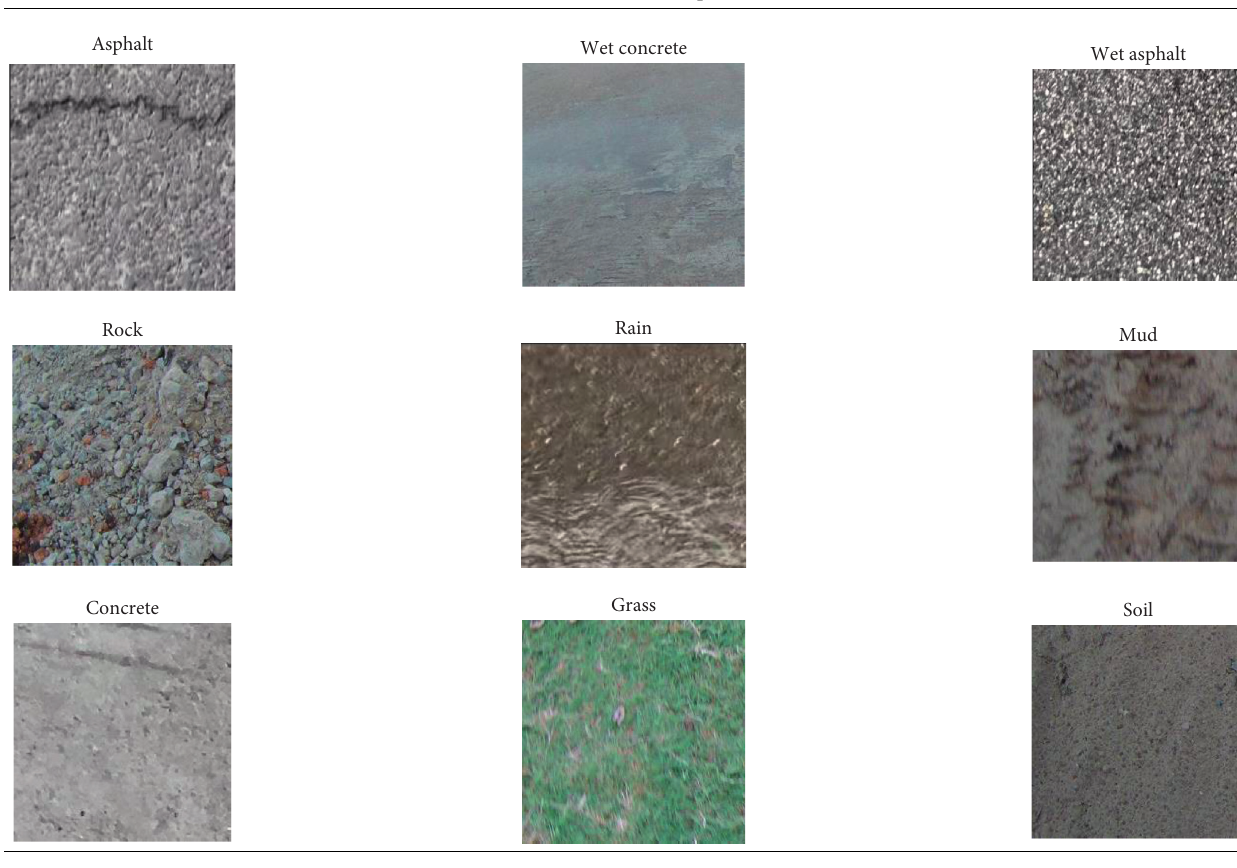
Table 4: Results of the test sample classification.